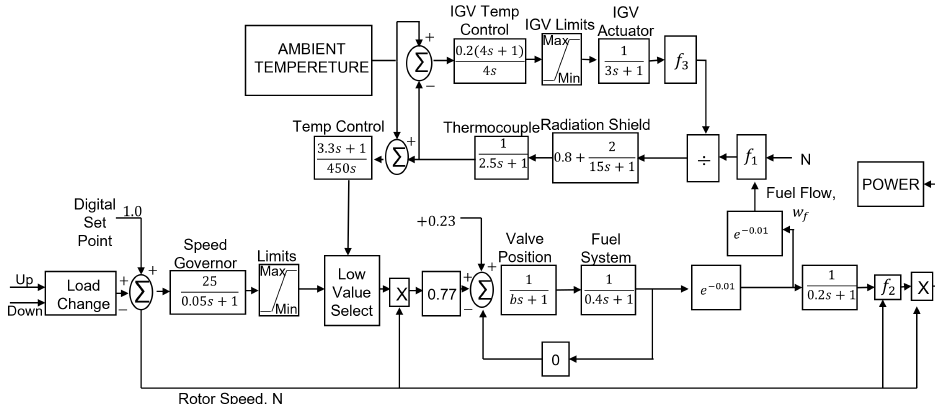
Figure 7. Rowen’s simplified semi-empirical model block diagram